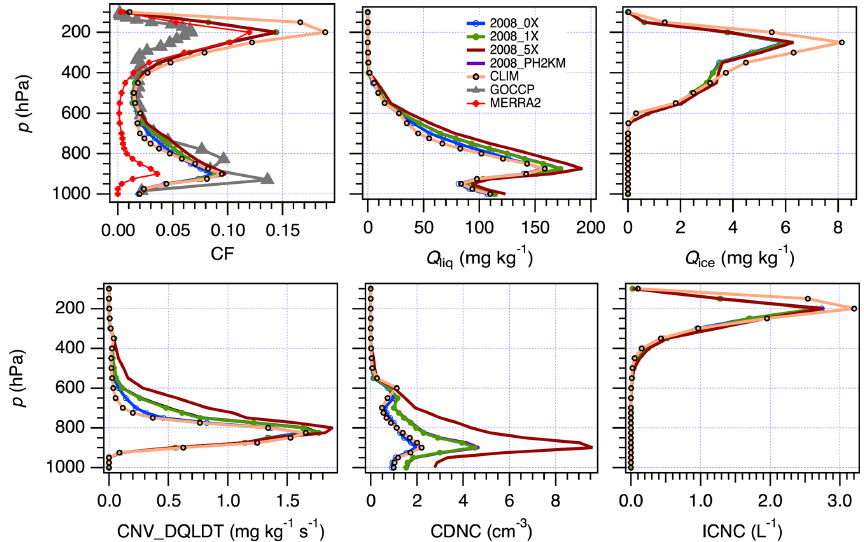
Figure 10. Zonal mean vertical profiles for cloud fraction (CF), liquid ( Q liq ) and ice ( Q ice ) mixing ratios, total detrained condensate tendency (CNV_DQLDT), cloud droplet (CDNC), and ice crystal (ICNC) number concentration for the 2008 JJA season. Notice that MERRA-2 and GOCCP data are included for CF only.